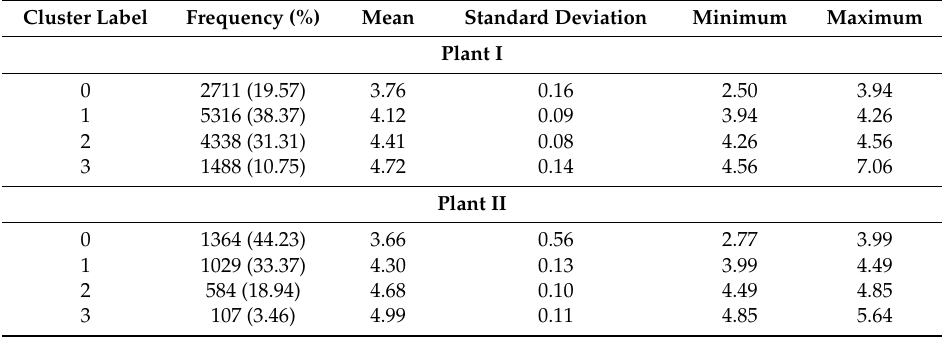
Table 2. Classification of l p based on the labels from K-means clustering for plant I and plant II. Cluster